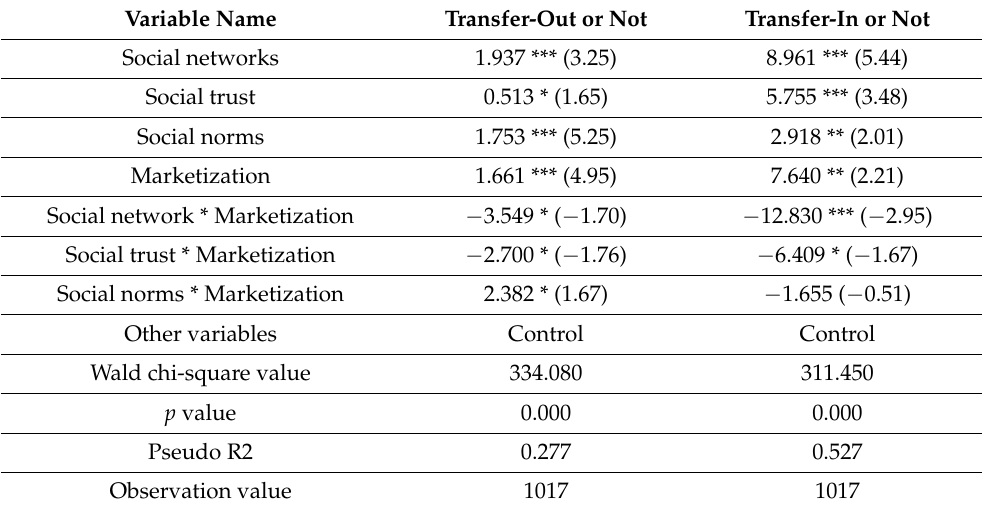
Table 10. Robustness test of regulation effect: interaction